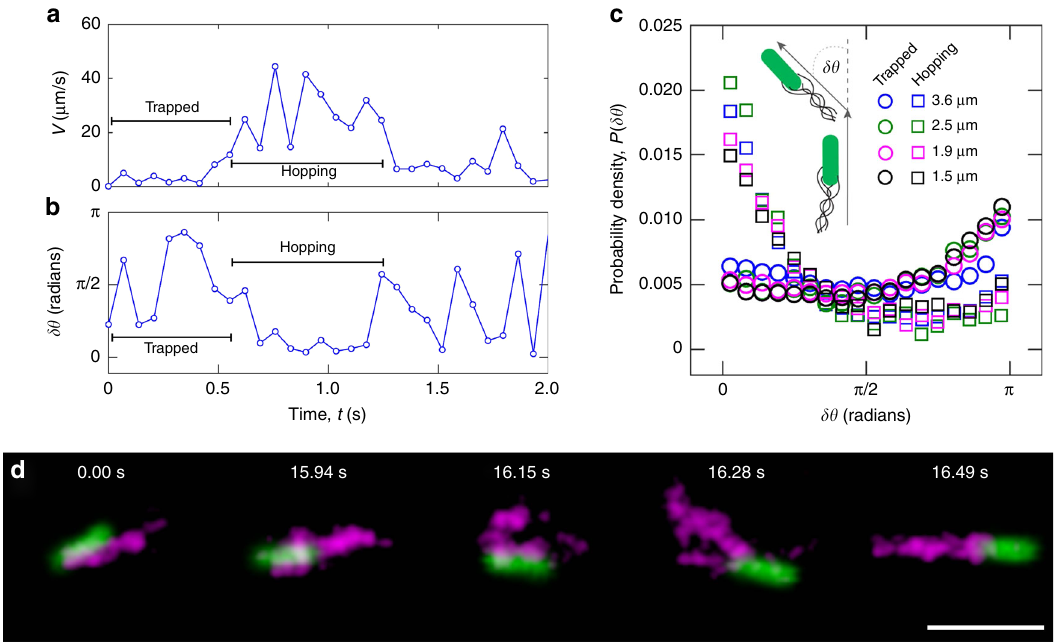
Fig. 3 Properties of hopping and trapping of bacteria in 3D porous media. a The instantaneous speed of a representative cell as it moves through the pore space shows intermittent switching between fast hopping and slow trapping. The experimental uncertainty is smaller than double the symbol size, as described in Methods. b The cell velocity reorientation angle also exhibits intermittent switching between hopping, with small δθ indicating directed motion, and trapping, with larger δθ indicating successive reorientations of the cell body. The maximal experimental uncertainty is smaller than double the symbol size, as described in Methods. c Distribution of reorientation angle for all hops (squares) and all traps (circles); legend indicates characteristic pore sizes of the different media. P ( δθ ) of hops is peaked at δθ = 0, indicating that hops are highly directed, while P ( δθ ) of traps is broadly distributed, indicating that motions of trapped cells are randomly oriented. d Direct labeling of fl agella (magenta) shows that they remain bundled when a cell is trapped ( fi rst two frames), indicating that fl agella unbundling is not required for trapping but instead that the cell has encountered a tight or tortuous spot. The cell body (green) continues to reorient itself, eventually enabling the fl agella to unbundle (third frame) and re-bundle in a different orientation (fourth frame), and enabling the cell to continue to move through the pore space in a different direction ( fi fth frame). Scale bar represents 5 μ